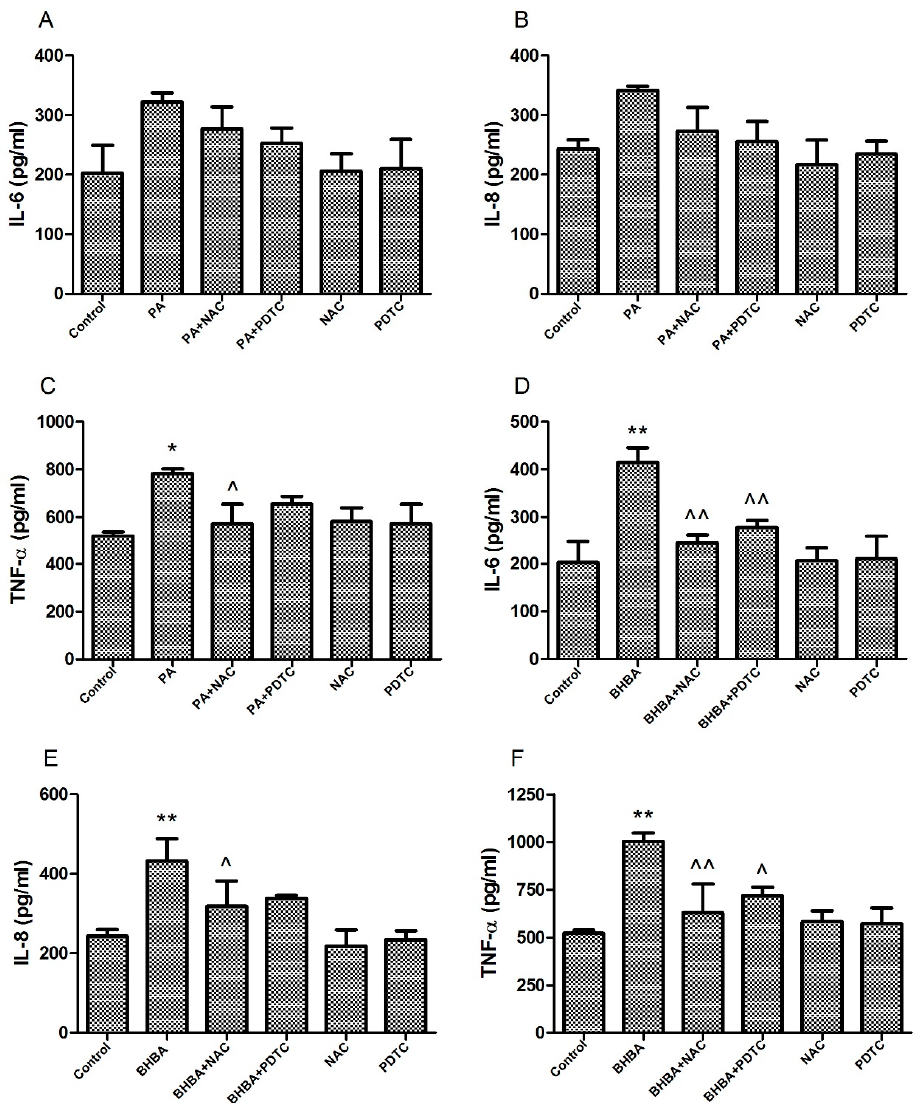
Figure 4. Levels of pro-inflammatory factors in the cell supernatants. ( A – C ) BEND cells were treated with 0.6 mM PA, 0.6 mM PA + 10 mM NAC (PA + NAC), 0.6 mM PA + 10 µ M PDTC (PA + PDTC), with 0.6 mM PA, 0.6 mM PA + 10 mM NAC (PA + NAC), 0.6 mM PA + 10 μ M PDTC (PA + PDTC), 10 mM NAC, or 10 μ M PDTC for 24 h. ( D – F ) BEND cells were treated with 2.4 mM BHBA, 2.4 mM BHBA 10 mM NAC, or 10 µ M PDTC for 24 h. ( D – F ) BEND cells were treated with 2.4 mM BHBA, 2.4 mM + 10 mM NAC (BHBA + NAC), 2.4 mM BHBA + 10 μ M PDTC (BHBA + PDTC), 10 mM NAC, or 10 BHBA + 10 mM NAC (BHBA + NAC), 2.4 mM BHBA + 10 µ M PDTC (BHBA + PDTC), 10 mM